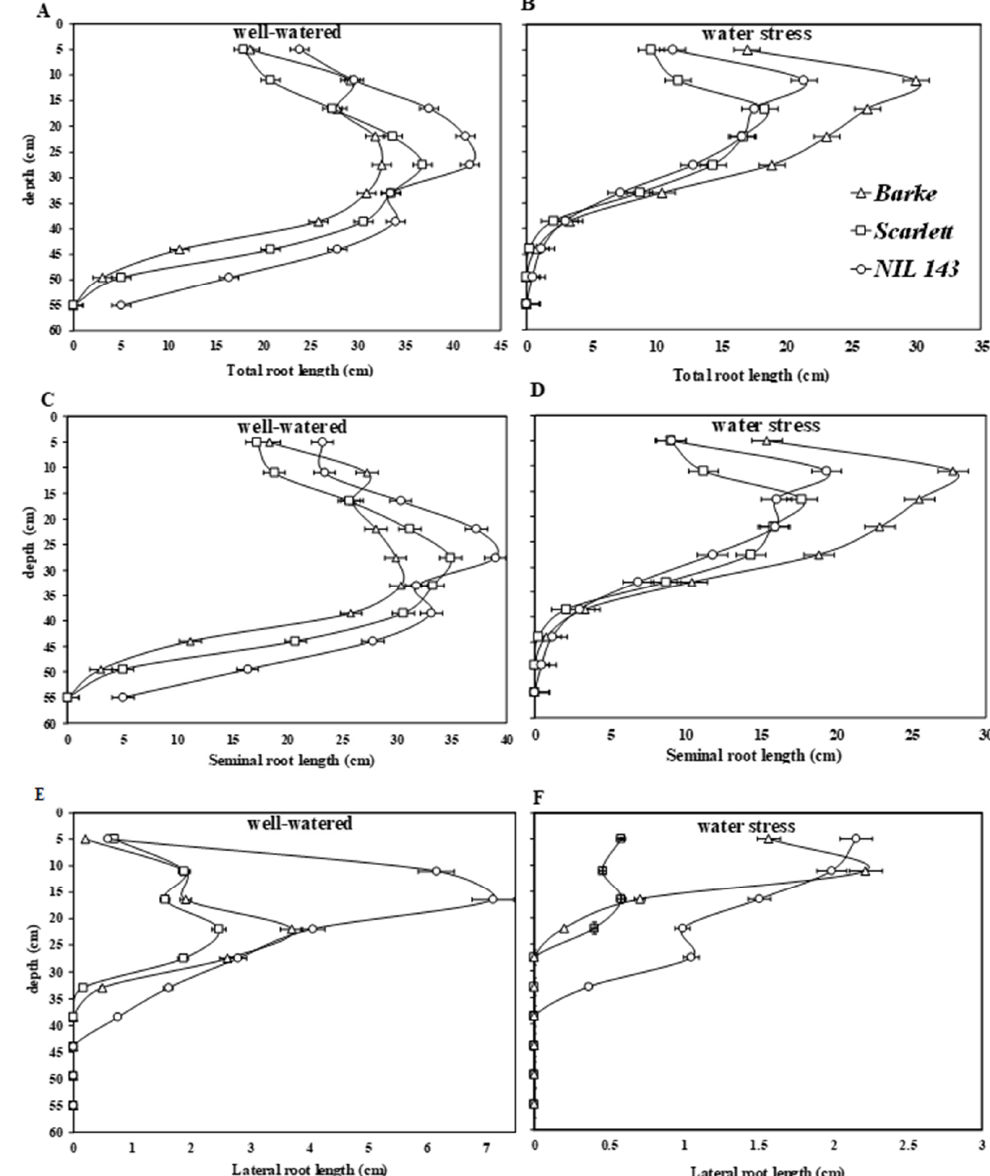
Figure 3. Visible root system placement along the soil profile (0–55 cm) in rhizoboxes for the different genotypes under WW and WS conditions 17 days after the onset of stress. In the panel: ( A )— visible total root length under well-watered; ( B )—visible total root length under water stress; ( C )— visible seminal root length under well-watered; ( D )—visible seminal root length under water stress conditions; ( E )—Visible lateral root length under well-watered; and ( F )—visible lateral root length under water stress conditions. Each point represents root growth averaged among six rhizoboxes per treatment (n = 6). Bars on top are standard errors.